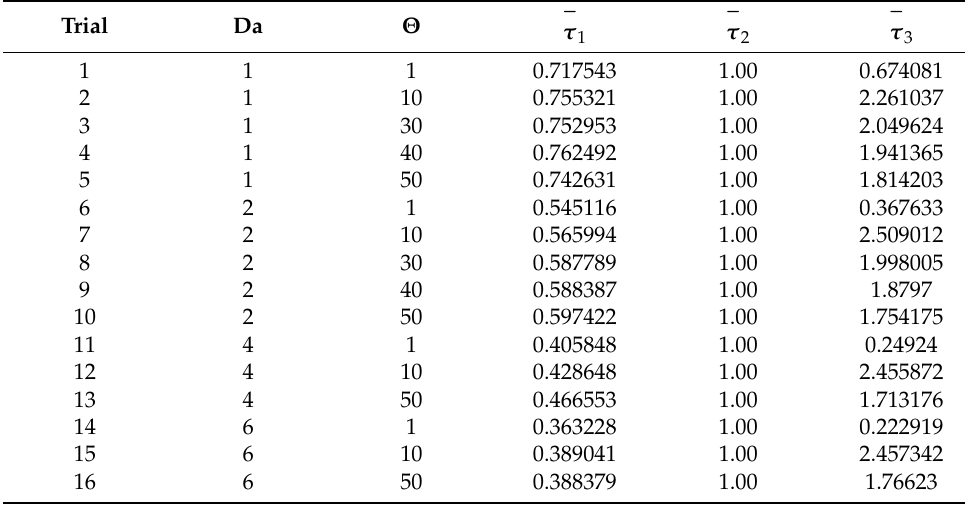
Table 3. MSR design parameters and OM dimensionless duration